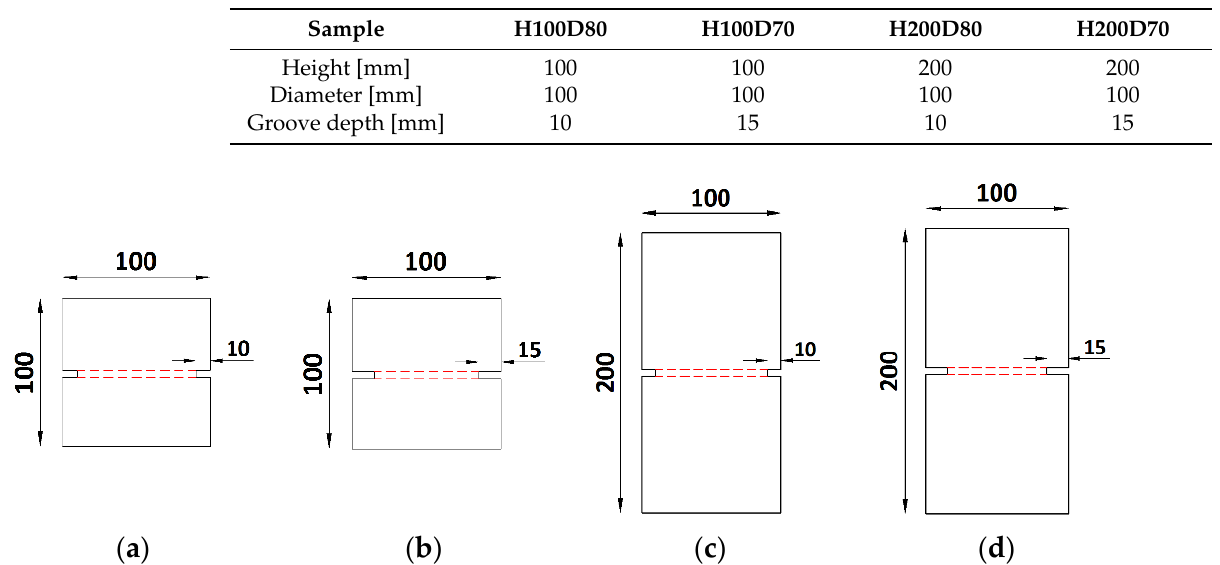
Figure 1. Specimen dimensions for: ( a ) H100D80; ( b ) H100D70; ( c ) H200D80; ( d ) H200D70.